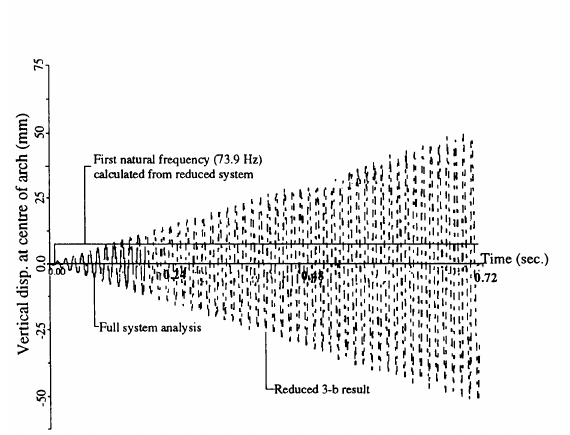
FIGURE 8 Shallow arch under sinusoidal excitation (w = 465 rad/s, p = 5 N). Central deflection response (assumed linear), 3-basis reduced system compared to full system analysis.